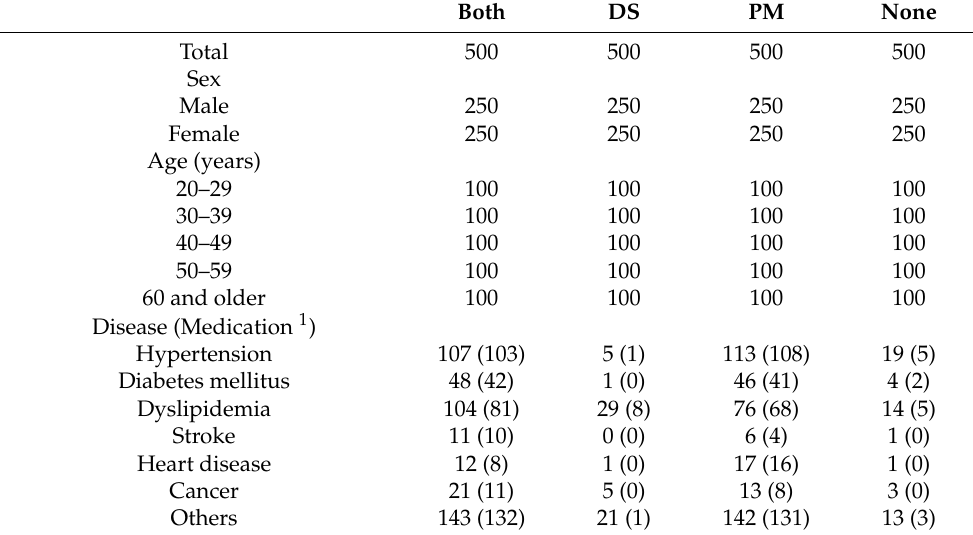
Table 5. Characteristics of